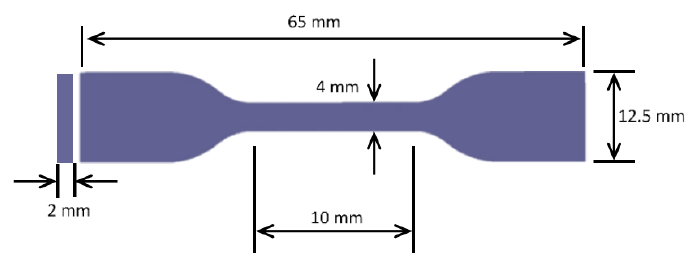
Figure 7. Specimen dimensions.